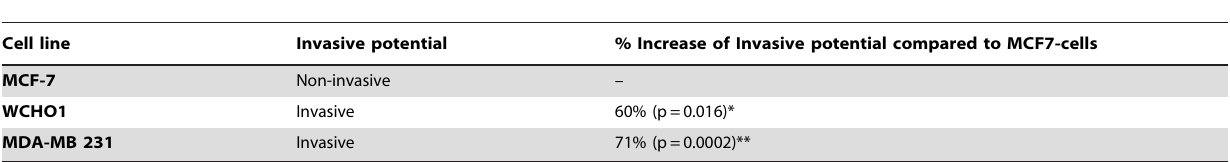
Table 1. Invasive potential of oesophageal and breast cancer